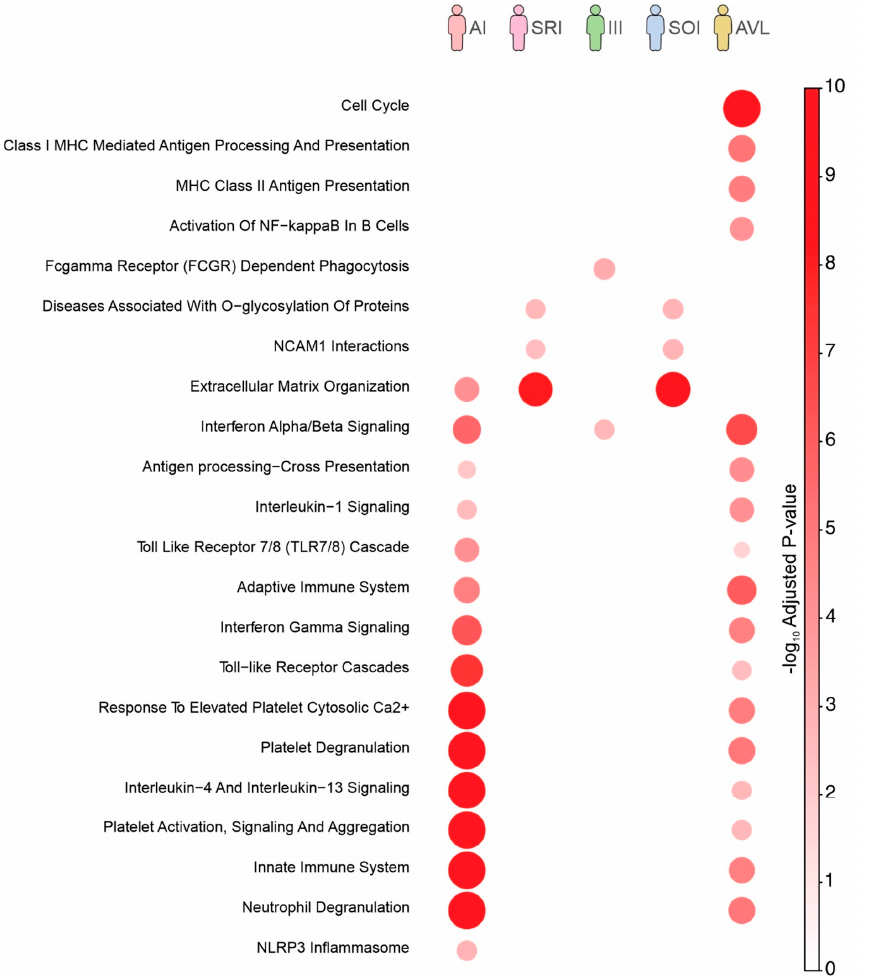
Figure 3. Reactome pathways enriched with genes up-regulated on each infection profile. The color and size of the circles are proportional to the significance of the